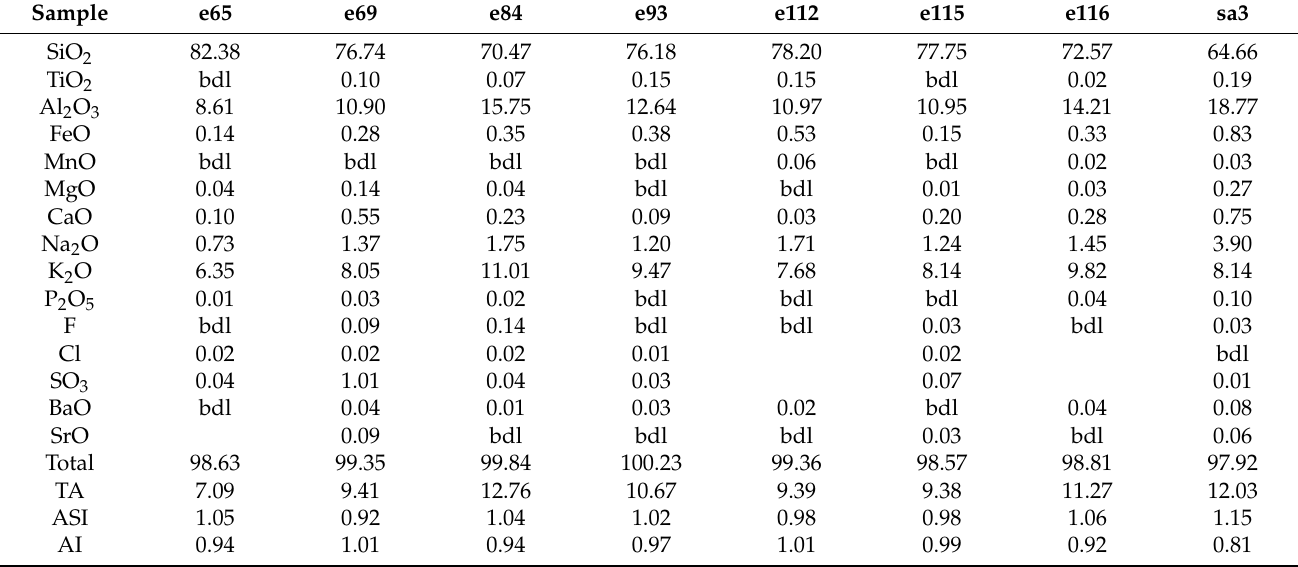
Table 1. Representative electron microprobe analyses of shard in the Tertiary volcanic tuff.